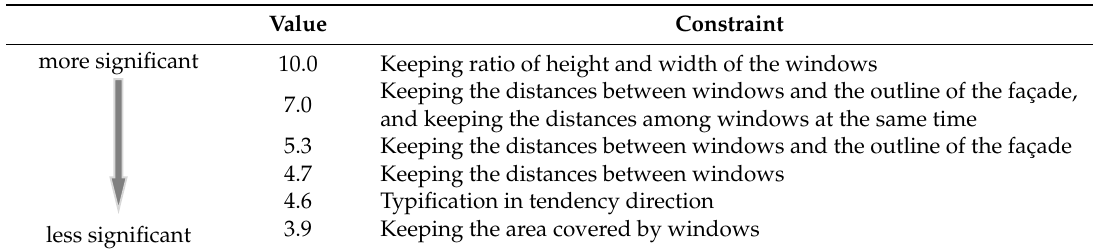
ISPRS Int. J. Geo-Inf. 2016 , 5 , 239 Table 2. Results of the user test for typification in decreasing order of significance. Table 2. Results of the user test for typification in decreasing order of Value